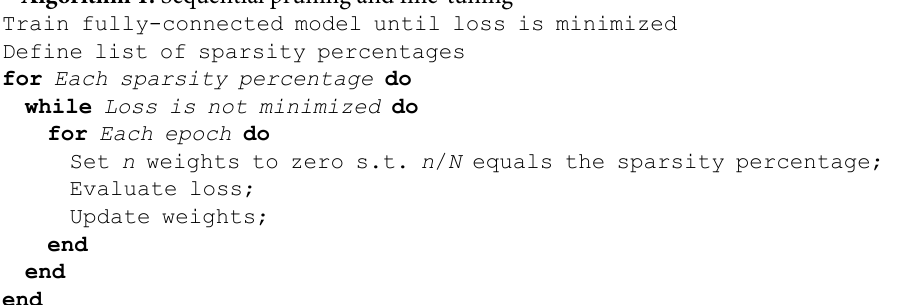
Algorithm 1: Sequential pruning and fine-tuning